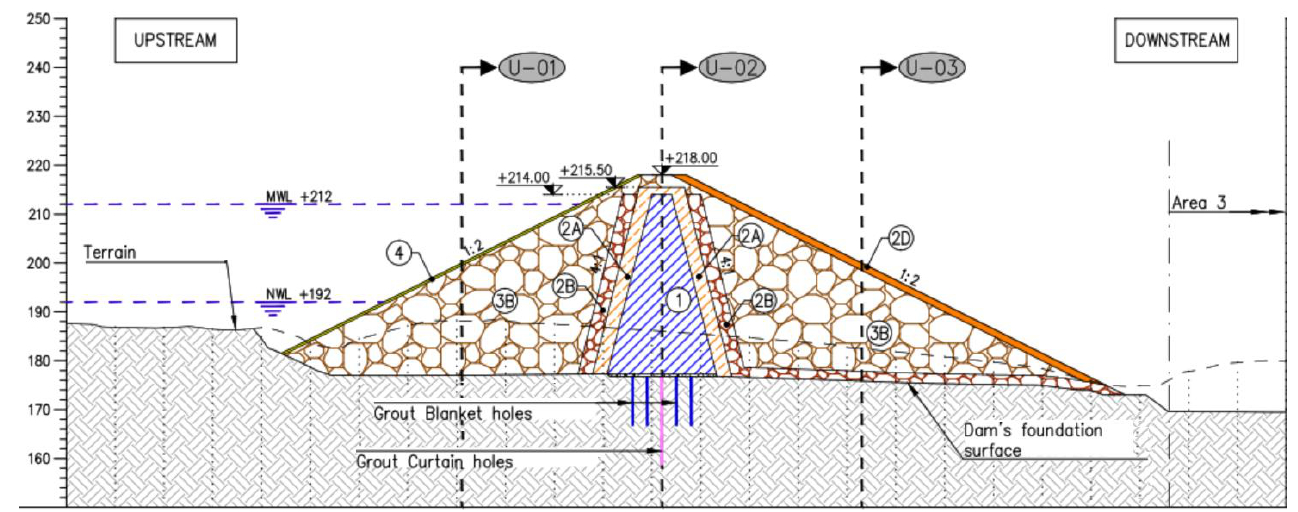
Figure 6. Upstream embankment engineering.